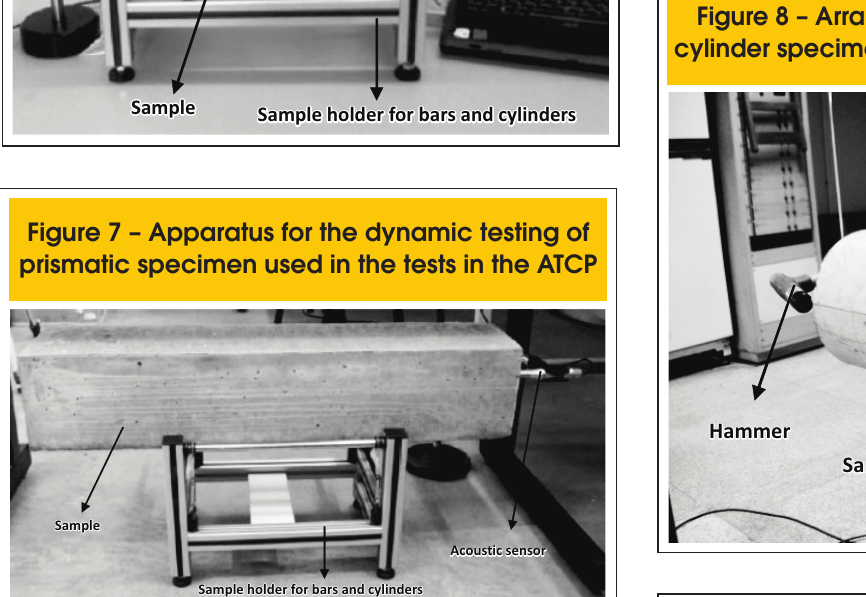
Figure 8 – Arrangement for dynamic testing of cylinder specimen used in the tests in the LE-EESC